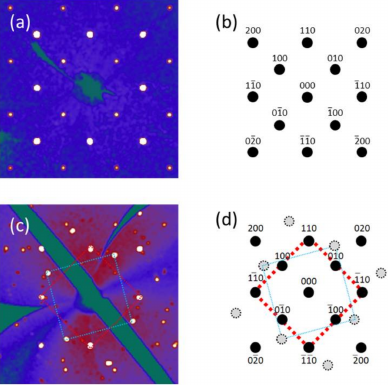
Figure 4. Reciprocal lattice plane of Bi 4 NbO 8 Cl along [001] direction for a crystal of ( a ) 120 µ m × 80 µ m × 20 µ m (Figure 3b) and ( c ) 340 µ m × 210 µ m × 40 µ m (Figure 3c) indexed with the P 2 1 cn cell as shown in ( b ) and ( d ),